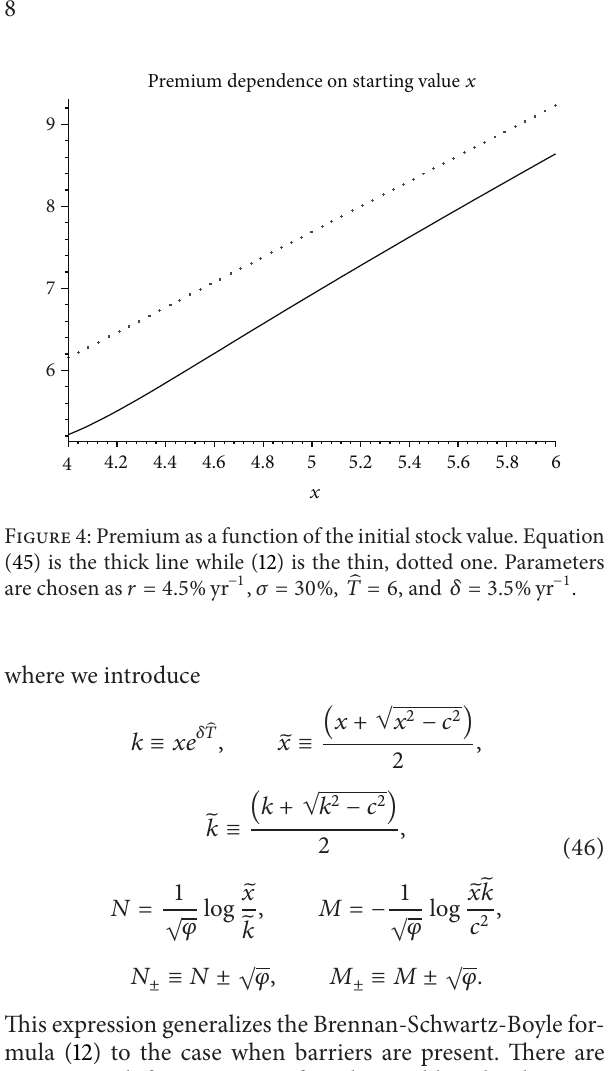
4.2. GULC of Type (ii) ( Ψ